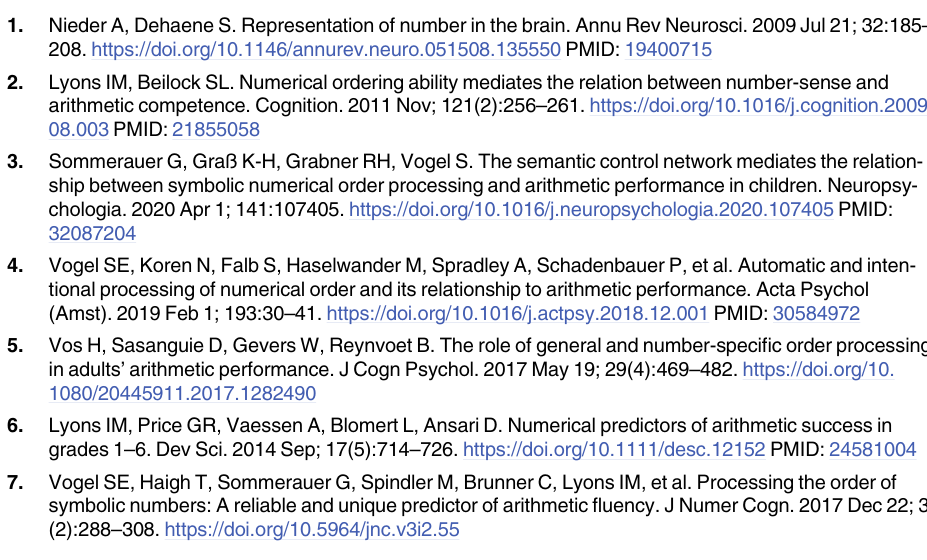
S4 Table. Hierarchical linear regression analysis predicting symbolic ordering in Grade 1, with non-symbolic magnitude comparison entered in the second step. Note. For all predic- tors, unstandardized regression coefficients are reported (standard errors in parentheses). r refers to the correlation between a given predictor and ordering